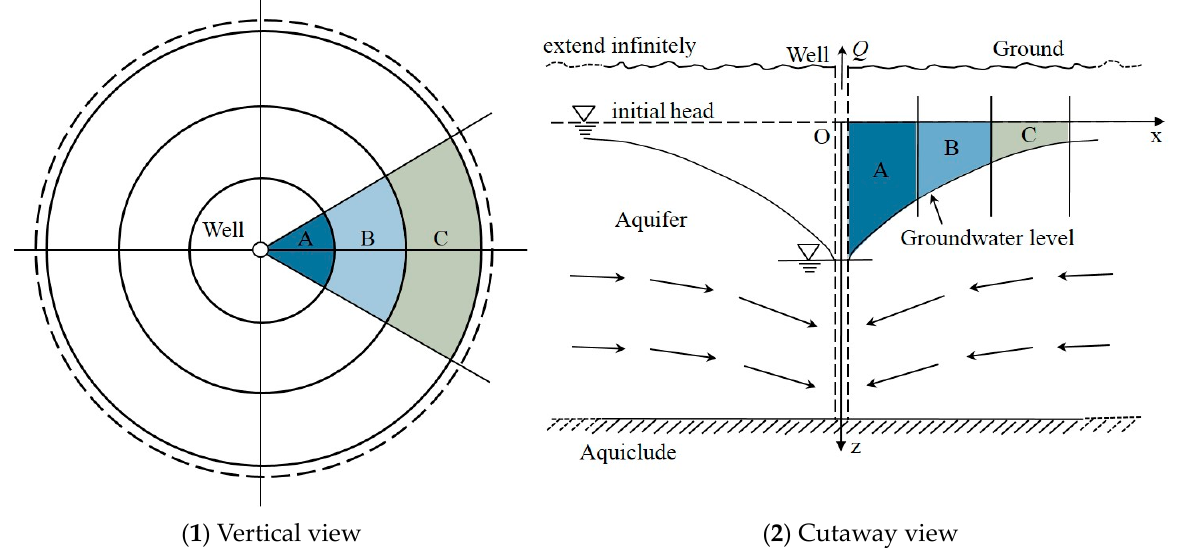
Figure 6. Formation of cone of depression of groundwater level during pumping. Q is the water yield of the pumping well, [L 3 T − 1 ].